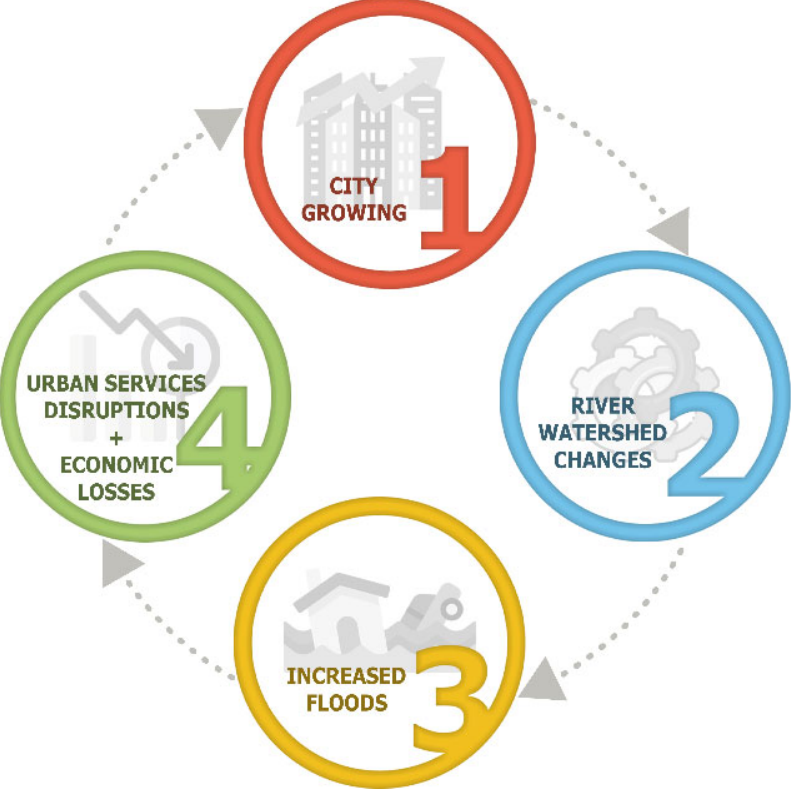
Figure 1. City degradation cycle caused by the failures in the urban drainage system.